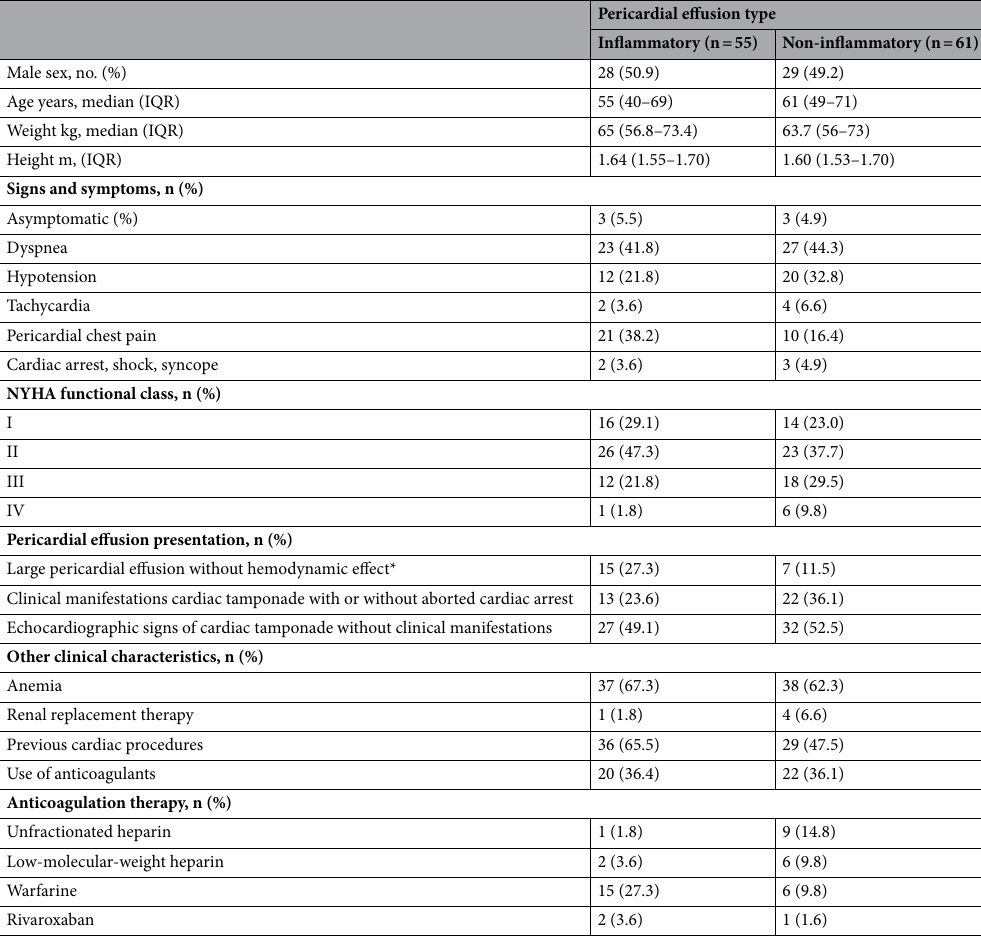
Table 1. Baseline clinical characteristics of the patients. *Large pericardial effusion without hemodynamic effect was significantly more frequent in the inflammatory group (p = 0.03).